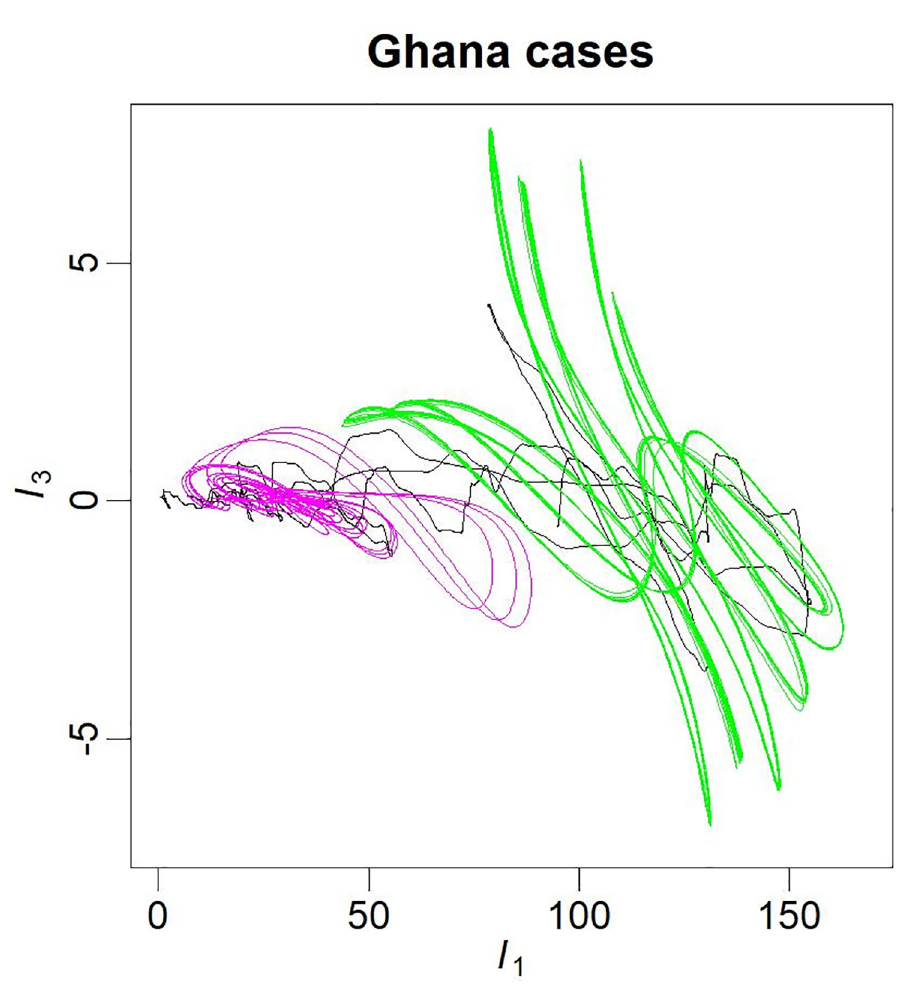
Fig 3. Differential phase portraits in ( I 1 , I 3 ) projection of the dynamics of daily new cases for Ghana. Observations (black lines) and model simulations (colored lines), are the same as the ones presented in Fig